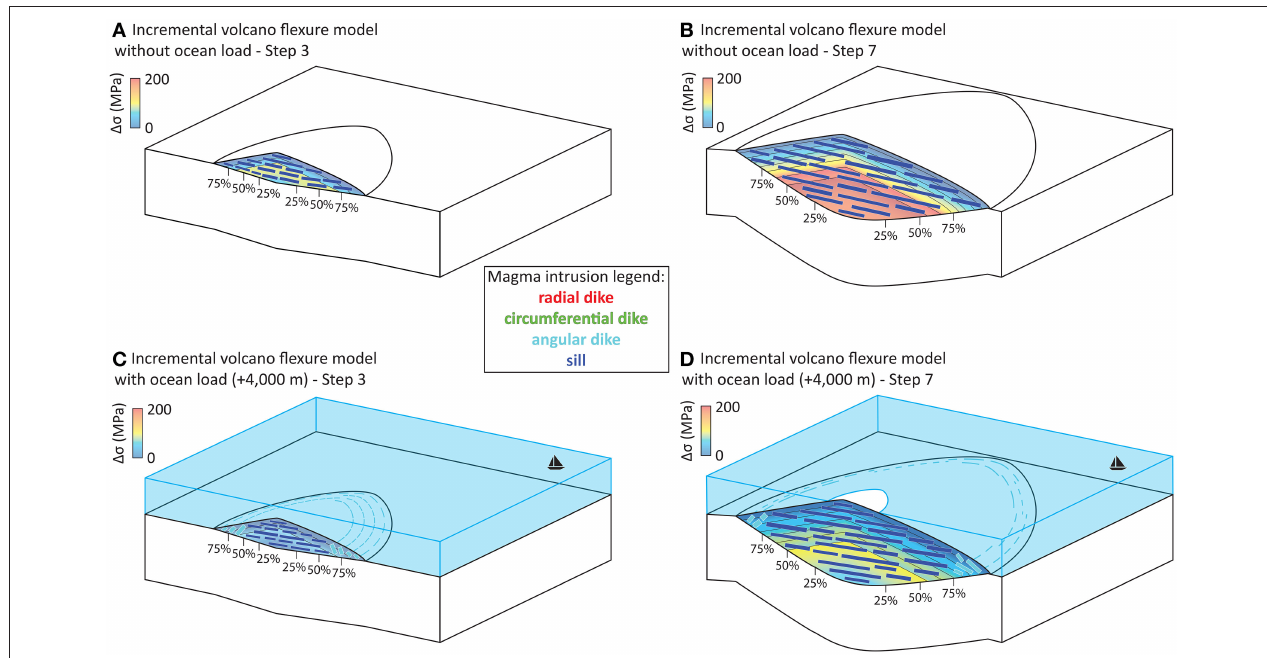
FIGURE 8 | Sketch illustrating the state of stress and the type of magmatic intrusions within incrementally-grown volcanoes for flexure models. Steps 3 (A) and 7 (B) of the model without an ocean load. Steps 3 (C) and 7 (D) of the model with an ocean load ( + 4,000m). Legend as in Figure 4 .